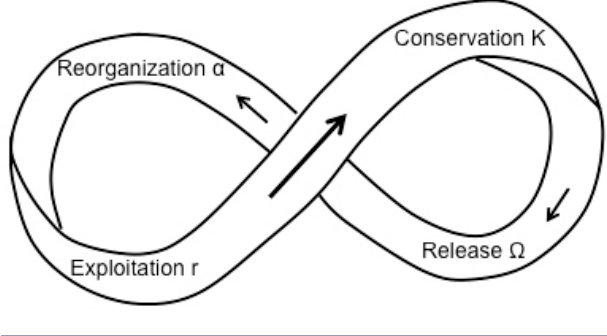
transformation (Walker et al. 2006). The phases of Ω and α comprise what is referred to as the “back loop” of the adaptive cycle (Abel et al. 2006, Walker et al. 2006). Fig. 1 . The adaptive cycle heuristic (From Panarchy edited by L. H. Gunderson and C.S. Holling. Copyright © 2002 Island Press. Reproduced by permission of Island Press, Washington,